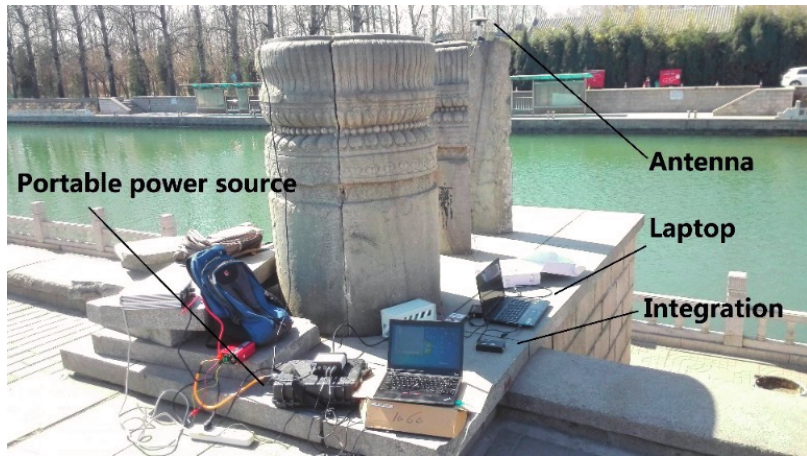
Figure 17. Experiment site in the map.